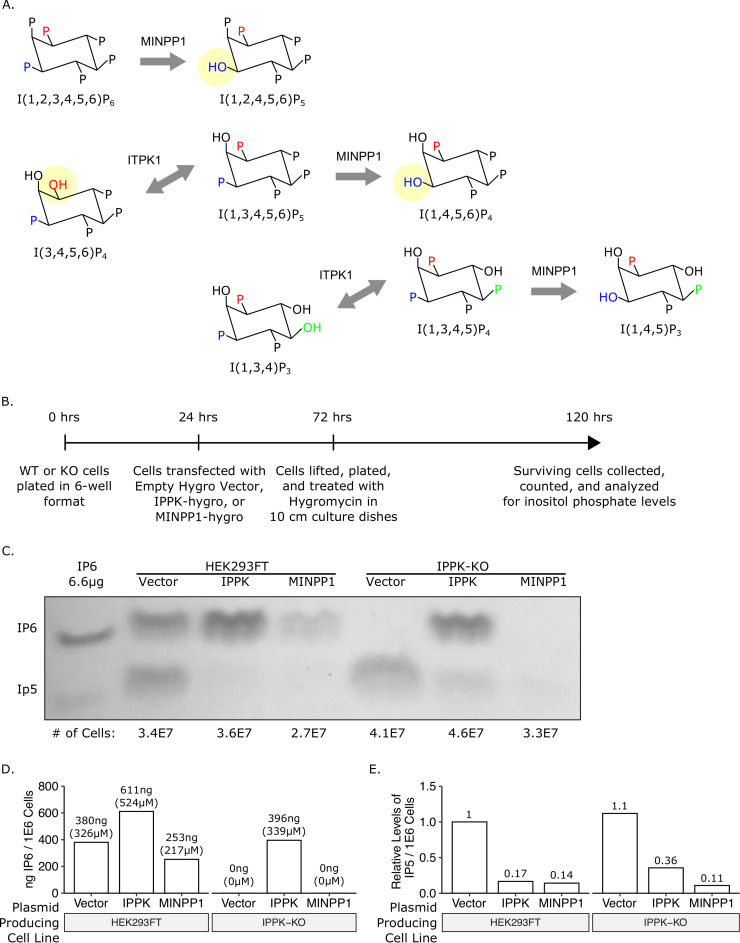
Addition of multiple inositol polyphosphate phosphatase 1 (MINPP1) removes endogenous IP6 and relevant IP5 species from cells.(A) Inositol phosphate pathway showing MINPP1 removal of the 3-position phosphate from IP6, IP5, and IP4. Removal of 3-phosphate from IP6 and I(1,3,4,5,6)P5 results in an equatorial hydroxyl group. (B) Experimental timeline. (C) 33% PAGE gel separating inositol phosphates. Dilution of purified 1 M IP6 was used as a standard and had an IP5 breakdown product. The number of cells in each sample is indicated. (D) IP6 quantification of panel C in ng per million cells and μM. (E) Relative IP5 quantification of panel C normalized to the HEK293FT control.